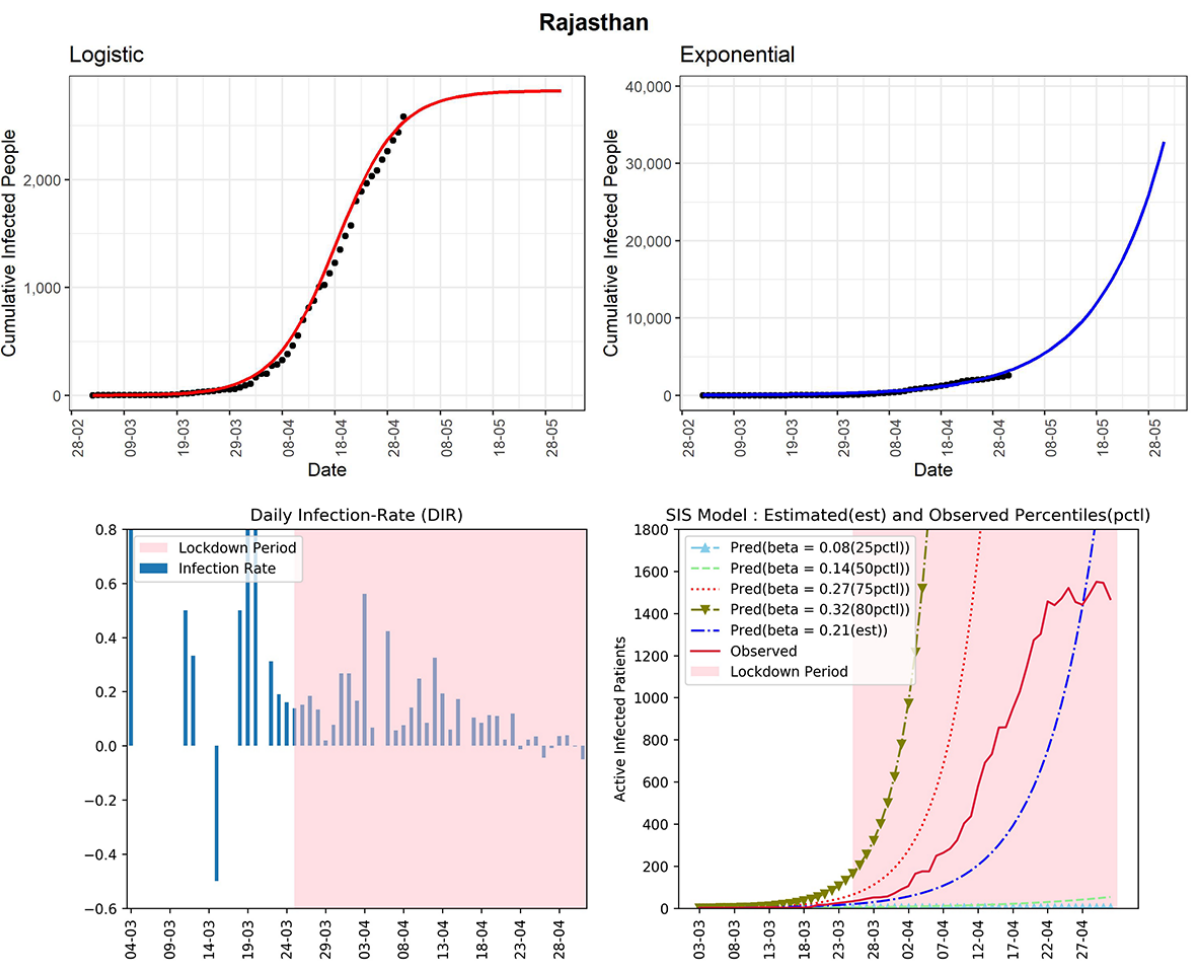
Figure 8. Graphs for the state of Rajasthan. SIS: